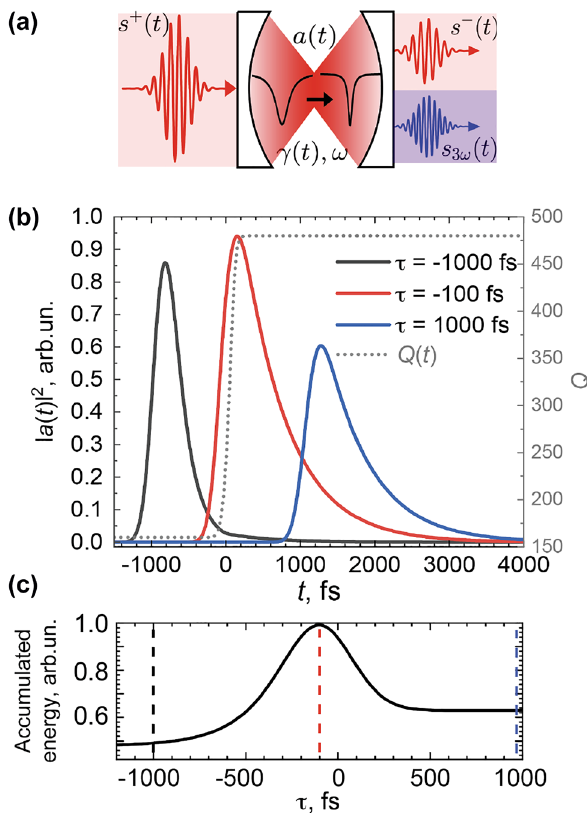
Figure 2: CMT results. (a) Formulation of the coupled-mode theory for a nonlinear Q-boosting metasurface. (b) Mode amplitude for three different values of the control–excitation delay 𝜏 : − 1000 fs, where the resonance is excited before the Q-boost; − 100 fs, where the Q-factor boosts right after the resonance is excited; and 1000 fs, where the excitation pulse arrives after the Q-boost. The dotted grey curve shows the time-dependent Q-factor. (c) Energy within the resonator ( U ( 𝜏 ) = ∫ +∞ −∞ | a ( t ,𝜏 ) | 2 d t ) as a function of 𝜏 , indicating the advantage of Q-boosting at 𝜏 ≈ − 100 fs. The dashed lines indicate the cases from panel (b) in corresponding colors (black, red, blue).